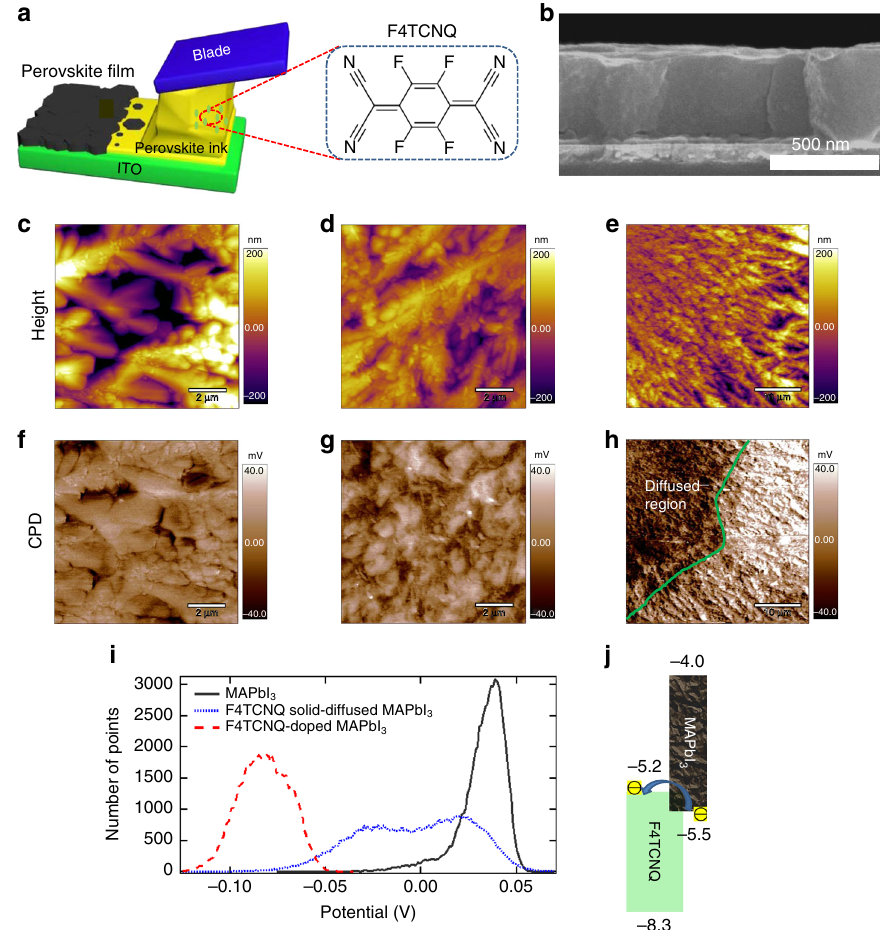
Fig. 1 Doctor blading and doping of perovskite fi lms by F4TCNQ. a Schematic illustration of a doctor-bladed perovskite fi lm and the chemical structure of F4TCNQ dopant. b Cross-sectional SEM image of the MAPbI 3 fi lm deposited directly onto ITO glass via bladed coating at 150 °C, showing the fi lm thickness of around 500 nm. Topography KPFM images of c , f MAPbI 3 , d , g F4TCNQ-doped MAPbI 3 , and e , h F4TCNQ solid-diffused MAPbI 3 fi lms. CPD represents the contact potential difference between the tip and sample ’ s surface. i Surface potential pro fi les of different perovskite fi lms as indicated. j Schematic illustration of the energy diagram and electron transfer process for MAPbI 3 :F4TCNQ